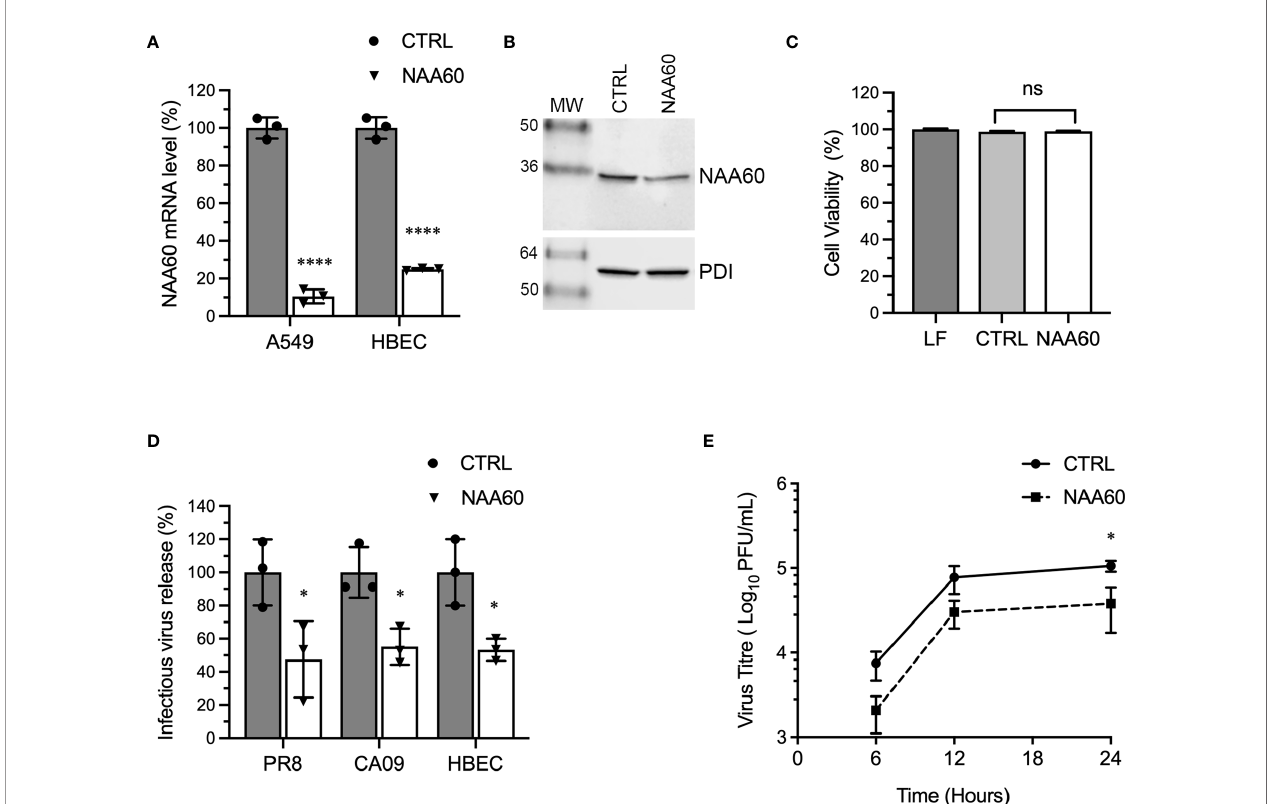
FIGURE 1 | The depletion of NAA60 expression decreases IAV infection. (A) A549 cells and HBECs were transfected with 10 nM of control (CTRL) siRNA or NAA60 siRNA for 72 h. Transfected cells were processed to detect the depletion of NAA60 expression by RT-qPCR. The detected NAA60 mRNA level in CTRL and NAA60 siRNA transfected cells were normalized to that of actin, based on which the relative NAA60 mRNA level was calculated by 2 – ΔΔ Ct method. Finally, the NAA60 mRNA level in CTRL siRNA ‐ transfected cells was considered 100% to determine its level in NAA60 siRNA-transfected cells. (B) A549 cells were transfected with 10 nM of CTRL or NAA60 siRNA for 72 h. The cells were processed and the NAA60 (29 kDa) and PDI (57 kDa) polypeptides were detected by western blotting. (C) A549 cells were transfected with lipofectamine (LF) only or in a complex with 10 nM CTRL or NAA60 siRNA for 72 h. The viability of cells was then measured by MTT assay. The cell viability in LF treated cells was considered 100% to determine the cell viability in CTRL and NAA60 siRNA transfected cells. (D) A549 cells and HBECs were transfected with either CTRL or NAA60 siRNA as above. Then, A549 cells were infected with either PR8 or CA09 and HBECs were infected with PR8 at an MOI of 1.0 for 24 h. The culture medium was collected and titrated by microplaque assay to measure the viral progeny release. The amount of viral progeny released from CTRL siRNA transfected cells was considered 100% to determine the amount of viral progeny released from NAA60 siRNA transfected cells. (E) A549 cells, transfected with CTRL or NAA60 siRNA for 72 h, were infected with PR8 at an MOI of 0.1, and the culture medium was collected at 6 h, 12 h and 24 h post-infection and titrated by microplaque assay. Error bars represent means ± standard deviation of at least three biological (A, D, E) or technical (C) replicates; ****P ≤ 0.0001, *P ≤ 0.05. MW, molecular weight; Grey bar, CTRL; White bar, NAA60; ns, nonsigni fi